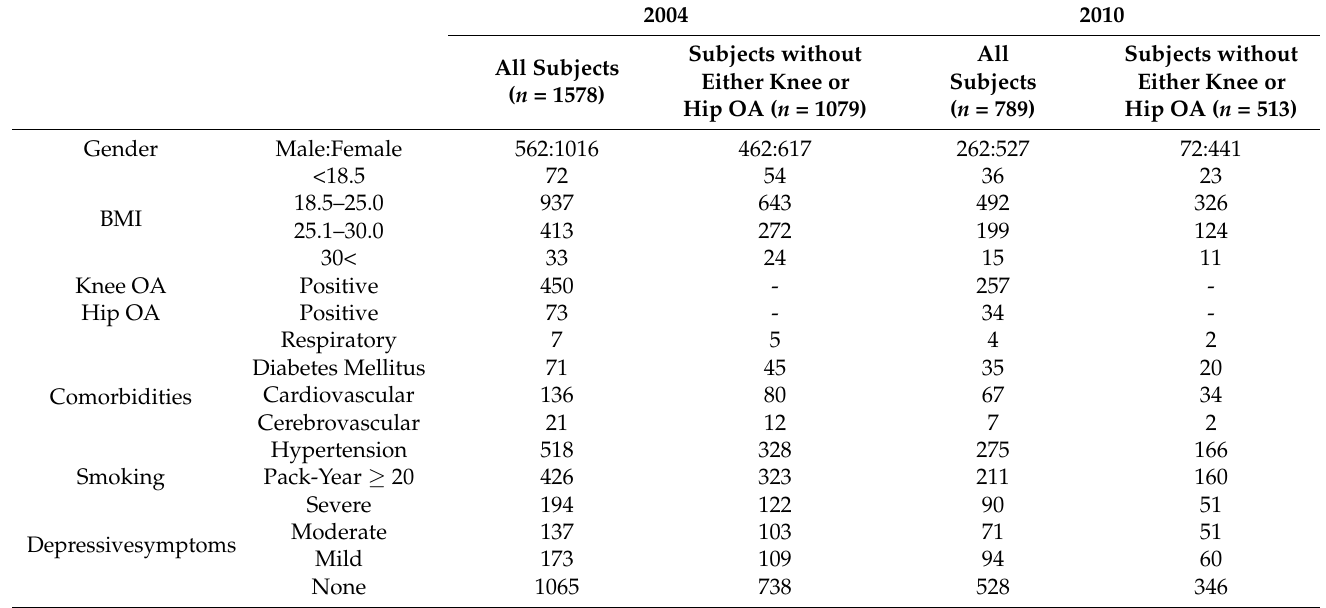
Table 2. Demographic data in 2004 and